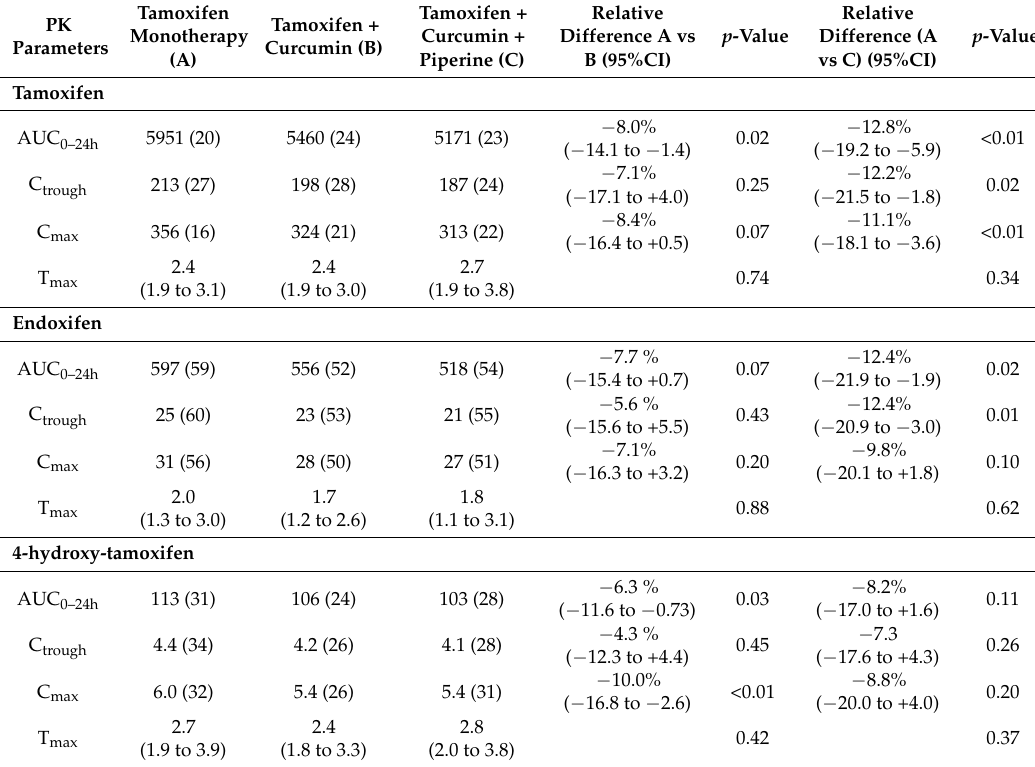
Table 2. Tamoxifen